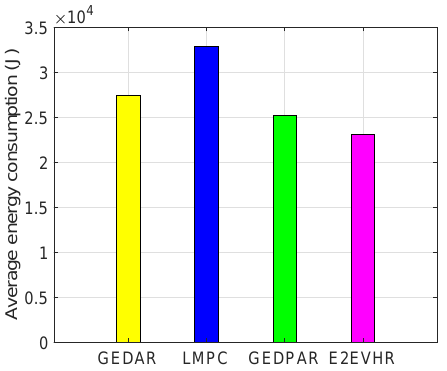
Figure 14. Average energy